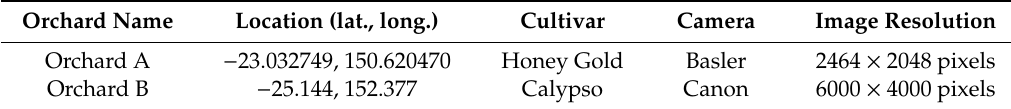
Table 1. Orchard and imaging description.